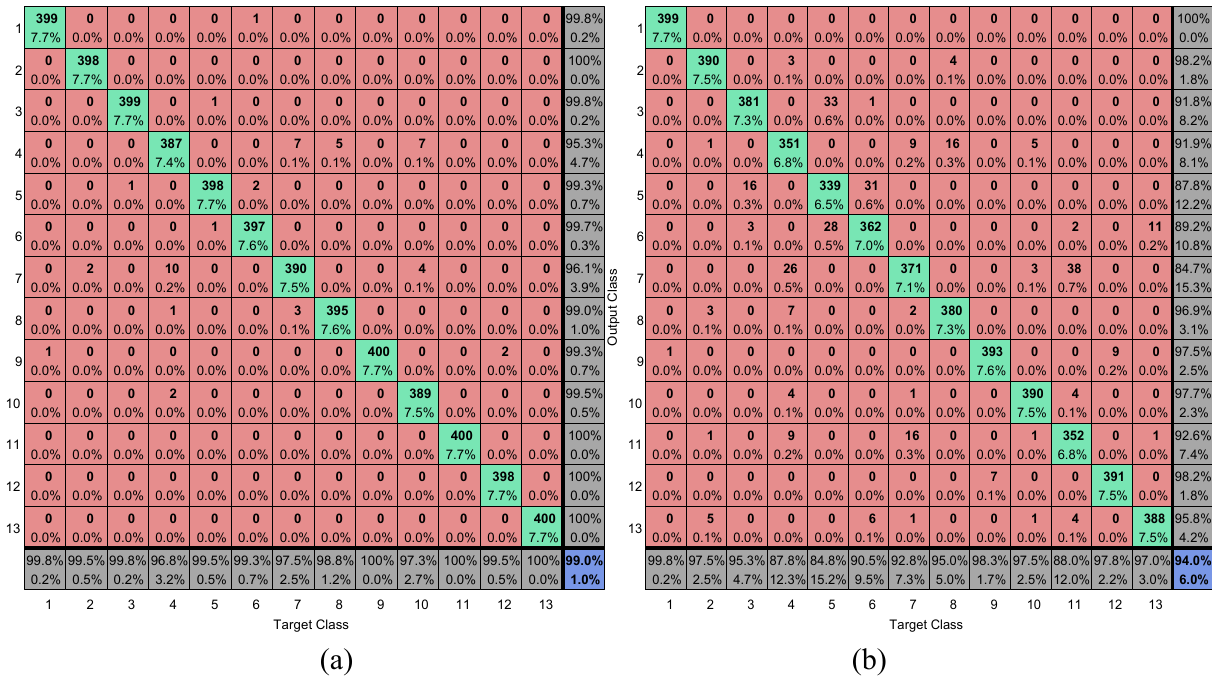
Table 8. A typical classification accuracy of different algorithms (Maximum iterations = 2,000). Algorithm